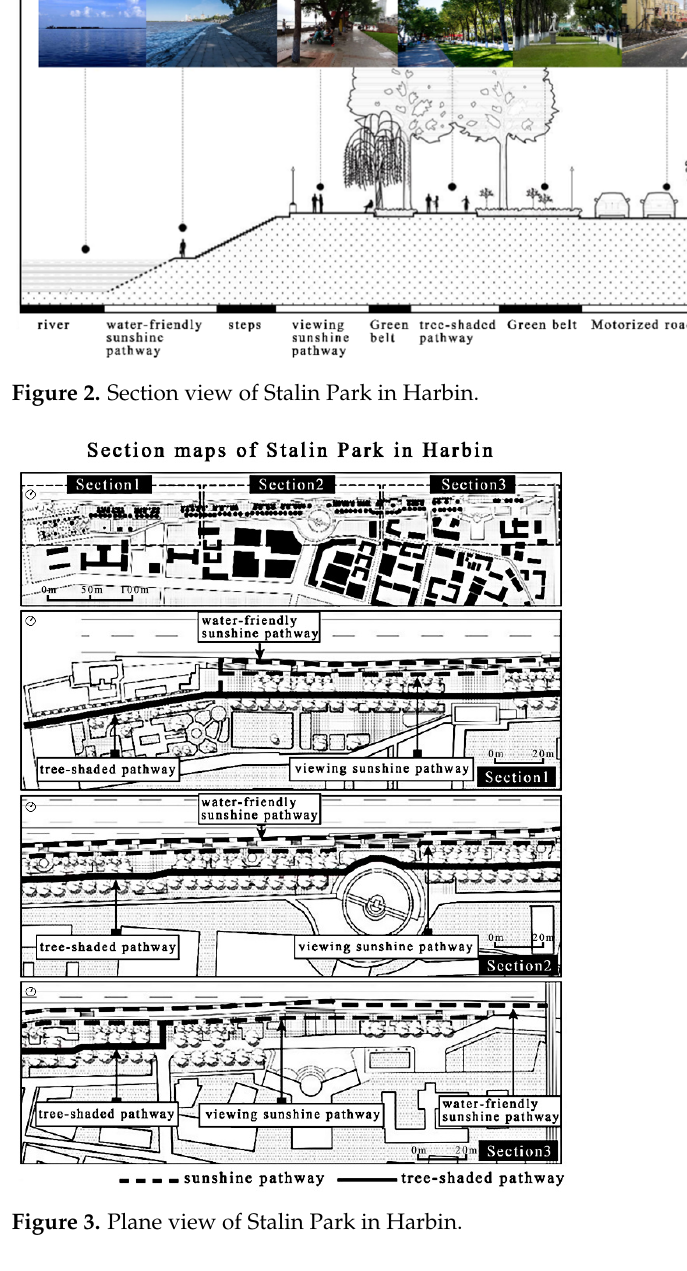
Figure 3. Plane view of Stalin Park in Harbin.